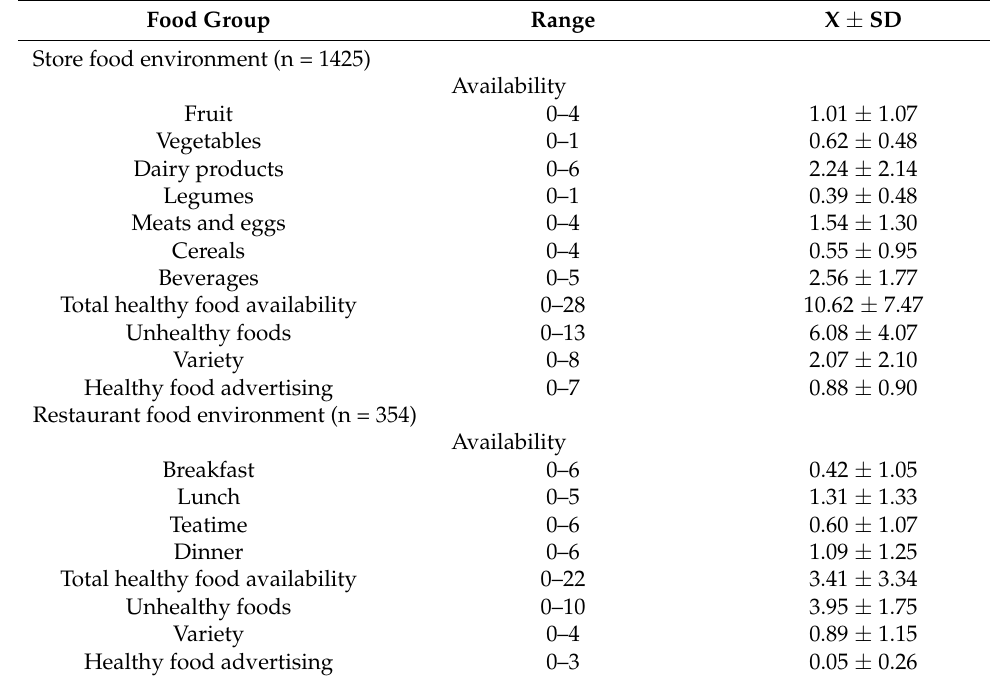
Table 4. Results of applied guidelines. Pilot study. Food Group Range Store food environment (n =